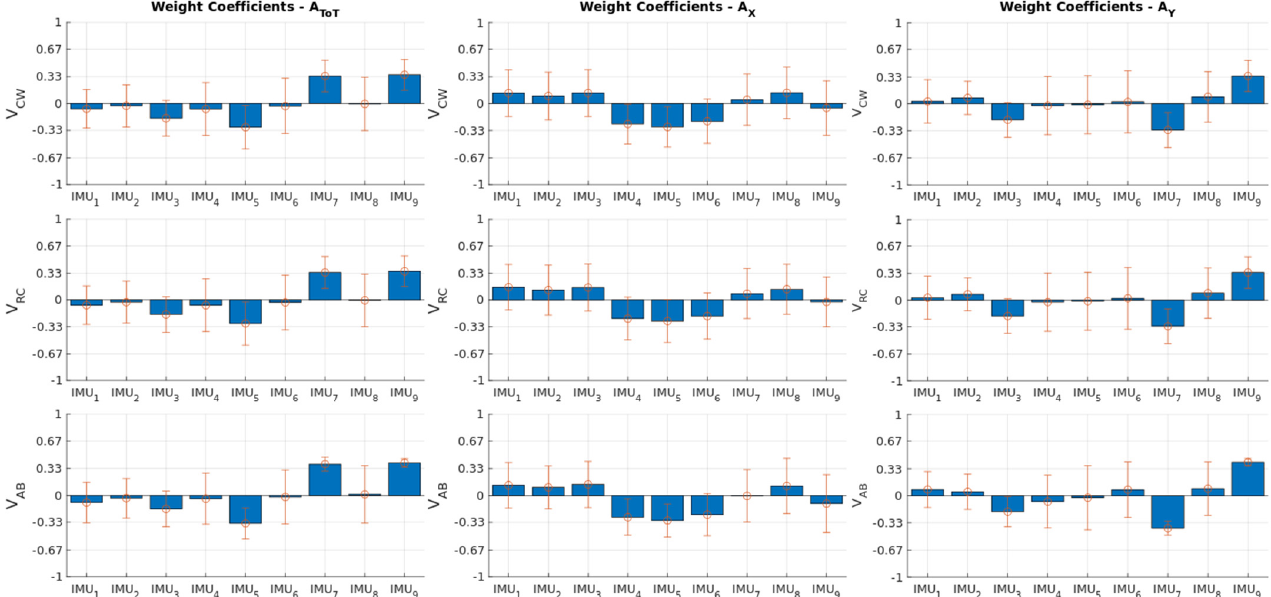
Figure 4. The subplots show the weight coefficients relating IMU outputs (from left to right: homologous data matrices Α ToT , Α X , and Α Y ) to retained PCs that best match with respiratory patterns (from top to bottom: V CW , V RC , and V AB ). The bars and error bars refer to the averaged and standard deviations across subjects, respectively.